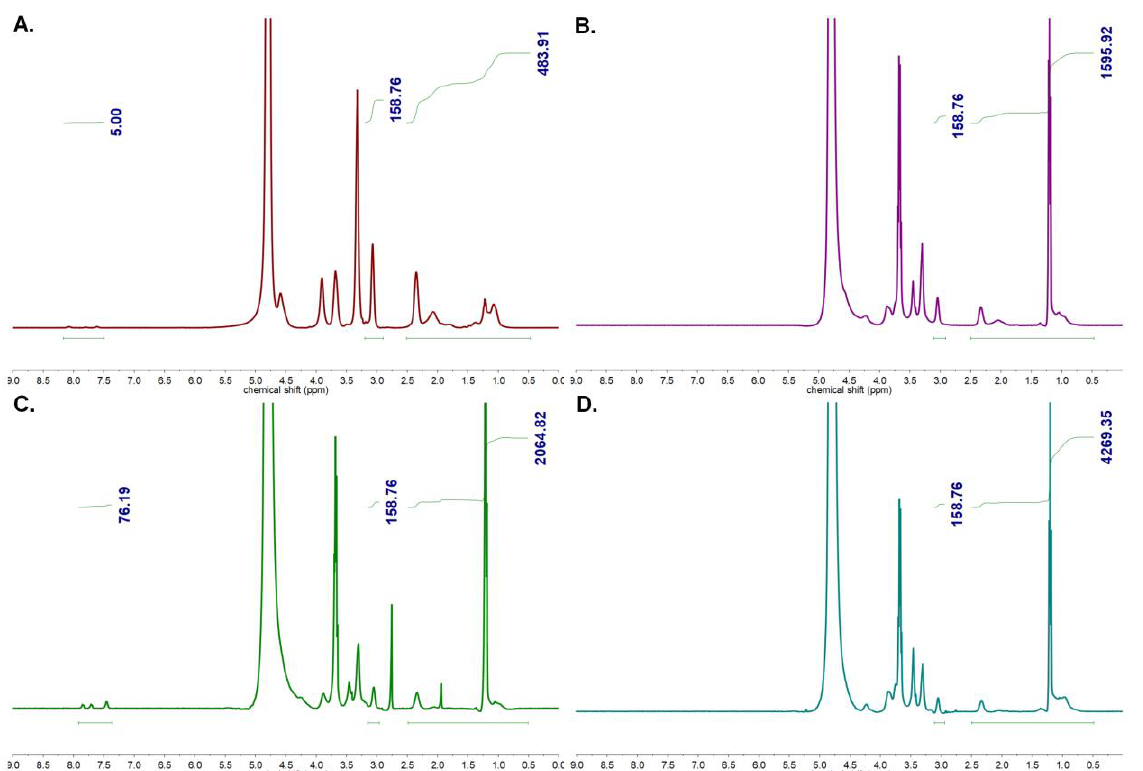
Figure 2. 1 H NMR spectrum of macroCTA ( A ), CCMs ( B ), peptide conjugated CCMs ( C ), and Herceptin conjugated CCMs ( D ) in D 2 O.